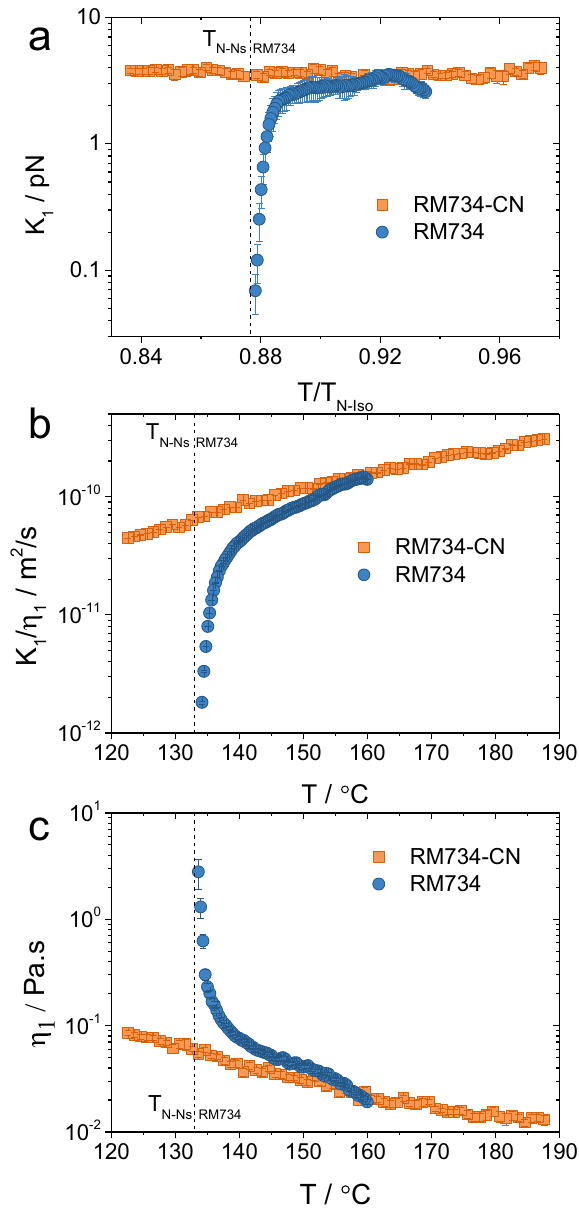
Fig. 3 Viscoelastic properties of RM734 and RM734-CN in the nematic phase. Temperature dependence of a the splay elastic constant K 1 b the ratios K 1 = η and c viscosities η for RM734 (blue full circles) (ref. 13 ) and RM734-CN 1 1 (orange full squares). While values for K 1 are obtained from the combination of dynamic light scattering intensities of the splay orientational fl uctuations and the Frederickz transition, diffusion coef fi cients K 1 = η are obtained from 1 the relaxation rates. Combination of both yields values of the viscosities. Comparison of results for both materials shows that the substitution of the nitro group by a nitrile group has a strong effect on the viscoelastic properties, hindering the softening of the splay elastic constant. Vertical dashed lines mark the N – N S transition temperature T N-Ns . Error bars correspond to on lowering the temperature, while a strong softening is detected for RM734 on approaching the N – N S transition. From the splay elastic constant and the diffusion coef fi cients K 1 / η 1 we obtained the temperature dependence of the splay viscosity (Fig. 3c), showing a steep increase before the N – N S transition for the RM734 as opposed to the classical Arrhenius-like tendency observed for RM734-CN.